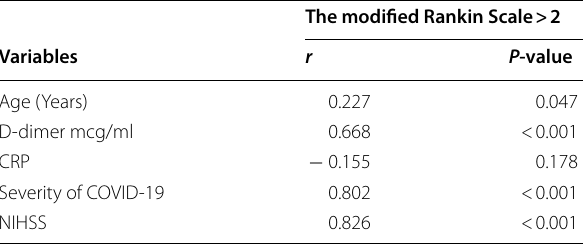
Table 4 Correlation between COVID-19 related data and outcomes at discharge